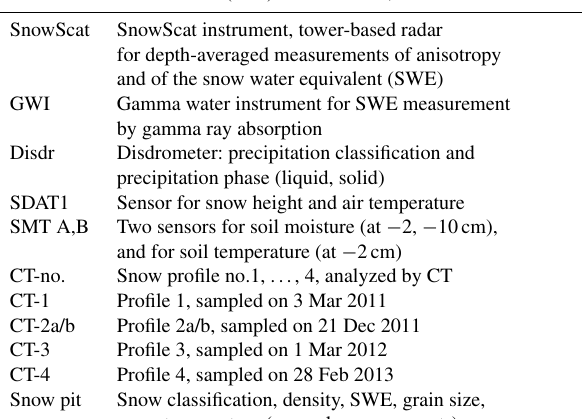
Table 2. List of field data for model input, calibration, and valida- tion. For each site, sensor abbreviations and full sensor names, or dataset abbreviation and type of measurements, are given.